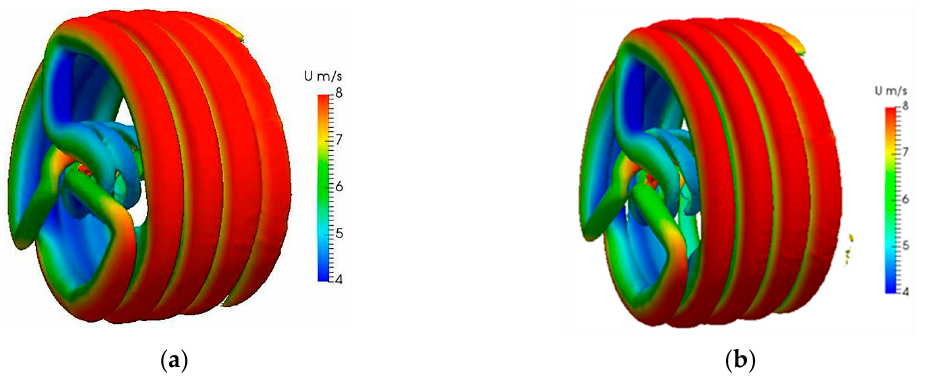
Figure 20. The wake structures in terms of Q field at 8 m/s: ( a ) by EALM; and ( b ) by ALM.